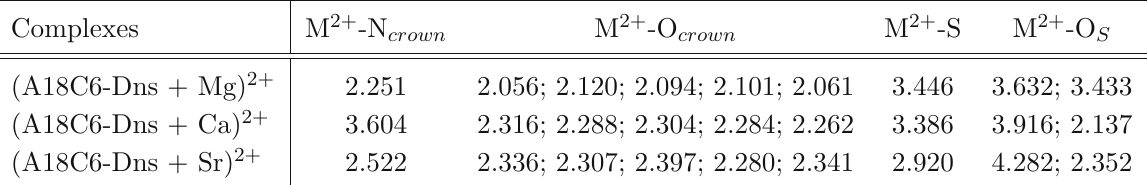
Table 4 The distances (˚ A) between cations and donor atoms in A18C6-Dns complexes with metal